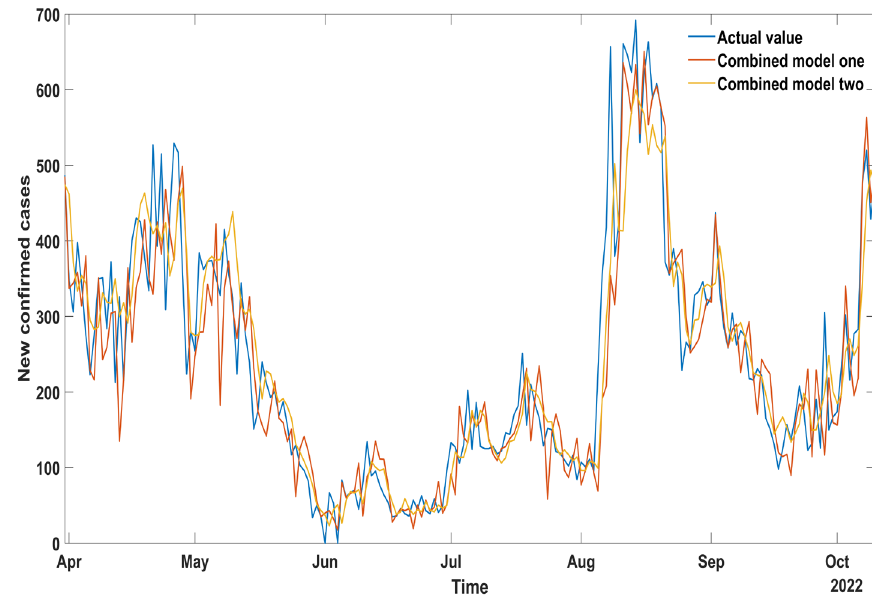
Figure 5. Comparison of the combined model and the true value. Table 3. Validation Metrics of the combined models.